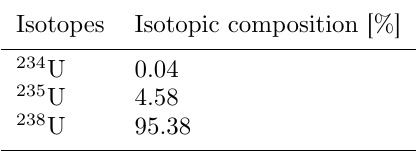
Table 2. UOx fresh isotopic composition (heavy metal weight fraction).